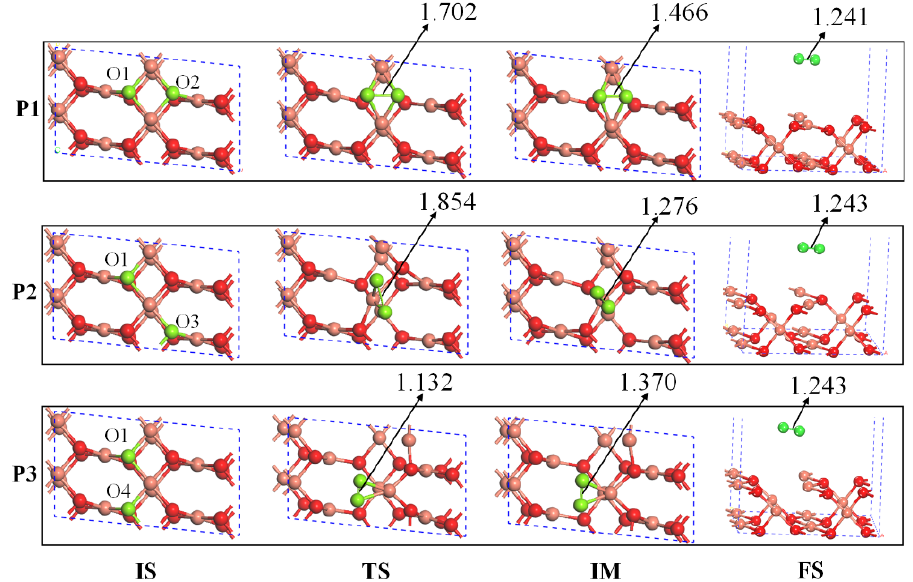
Figure 1. The initial state (IS), transition state (TS), intermediate state (IM), and final state (FS) structures for the O 2 formation and O 2 desorption processes in different pathways on the CuO(110) surface of O-terminated. The bond lengths are presented in Å. The salmon pink and red spheres denote Cu and O atoms, respectively.